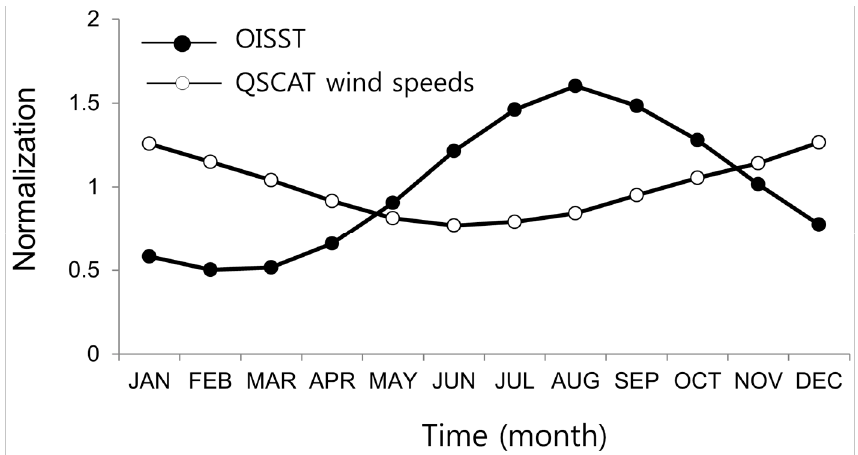
Figure 3. Normalized monthly variation of the spatial averaged OISST (lines with closed dots) and the QSCAT wind speeds (lines with opened dots) for the time-series analysis period.